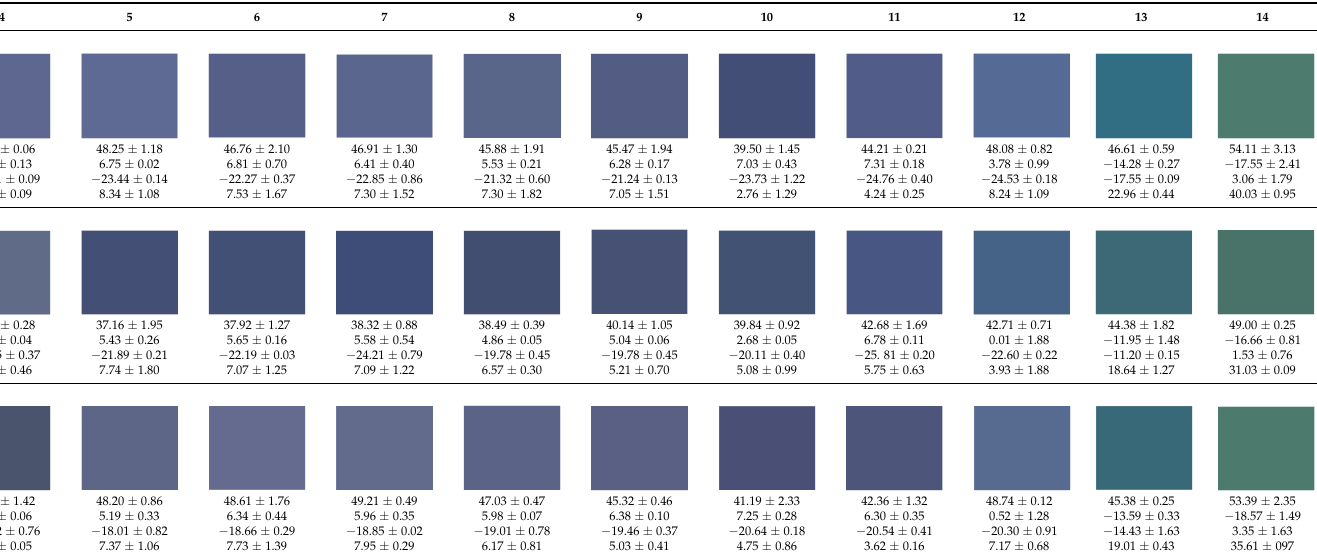
Table 5. Apparent color, colorimetric parameters, and total color difference ( ∆ E ) of the BC-violacein indicator at different pH values (1 to 14), first row contains initial values, second row contains the data obtained after light exposure (120 h), and the third row consist of data after storage at 4 ◦ C (120